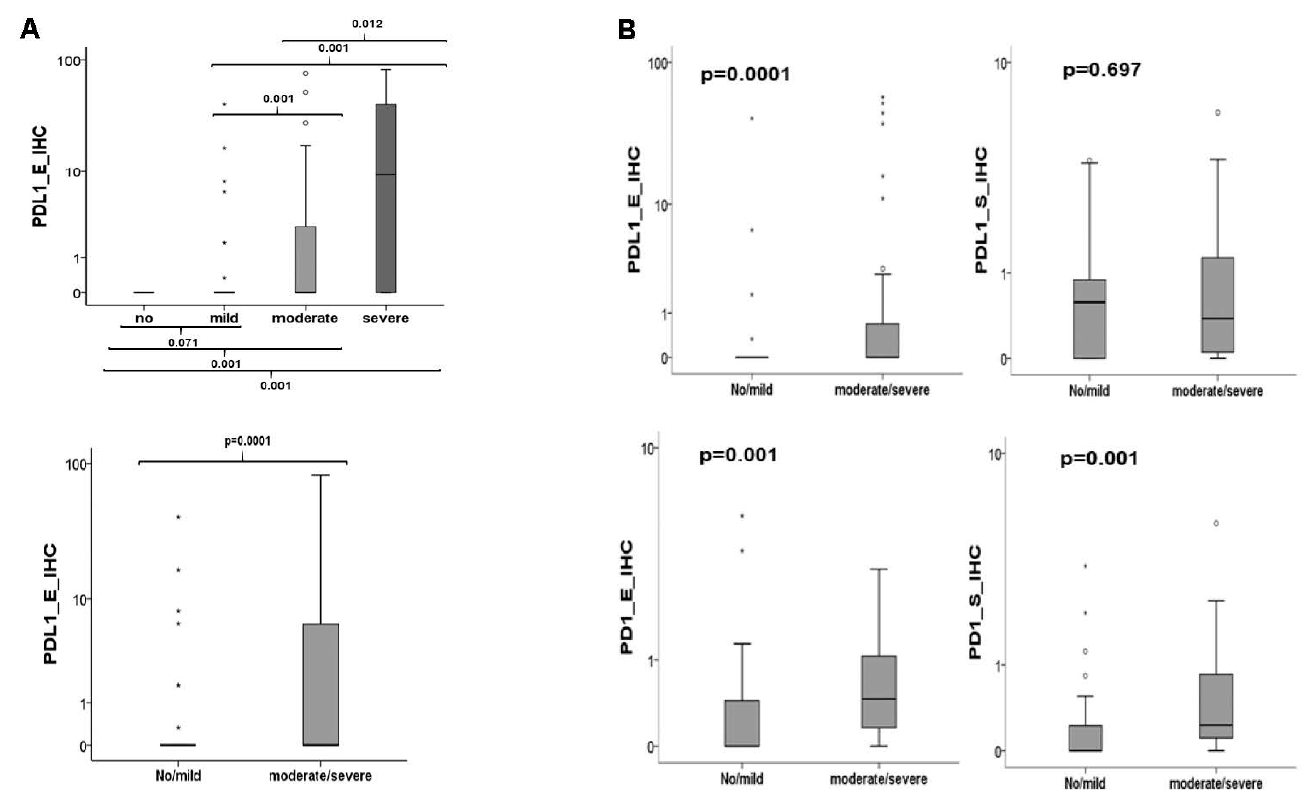
Figure 8. Association between inflammation and checkpoint expression. ( A ) If all groups are included in the evaluation PD-L1 expression in the epithelial part of the specimens is statistically associated with the severity of inflammation. ( B ) If only the groups of OLP were included in the analysis a significant relationship between overexpression of PD-1 (epithelial/subepithelial) and of PD-L1 (epithelial) to high inflammation could be seen.